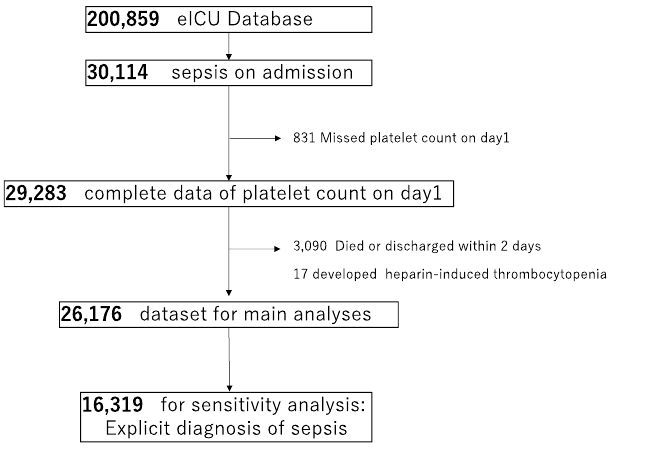
Figure 1. Flow diagram of patient